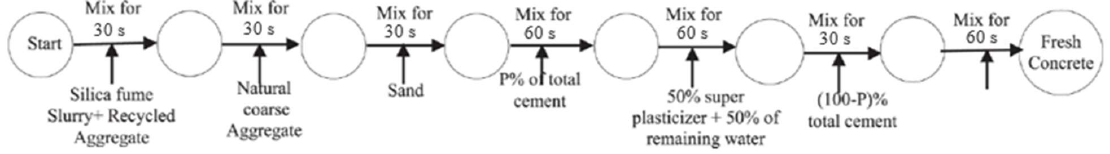
Figure 11. SEM images of new ITZ after ( a ) TSMA; ( b ) normal mixing [42]. Reproduced with permission from [42], Elsevier, 2005.